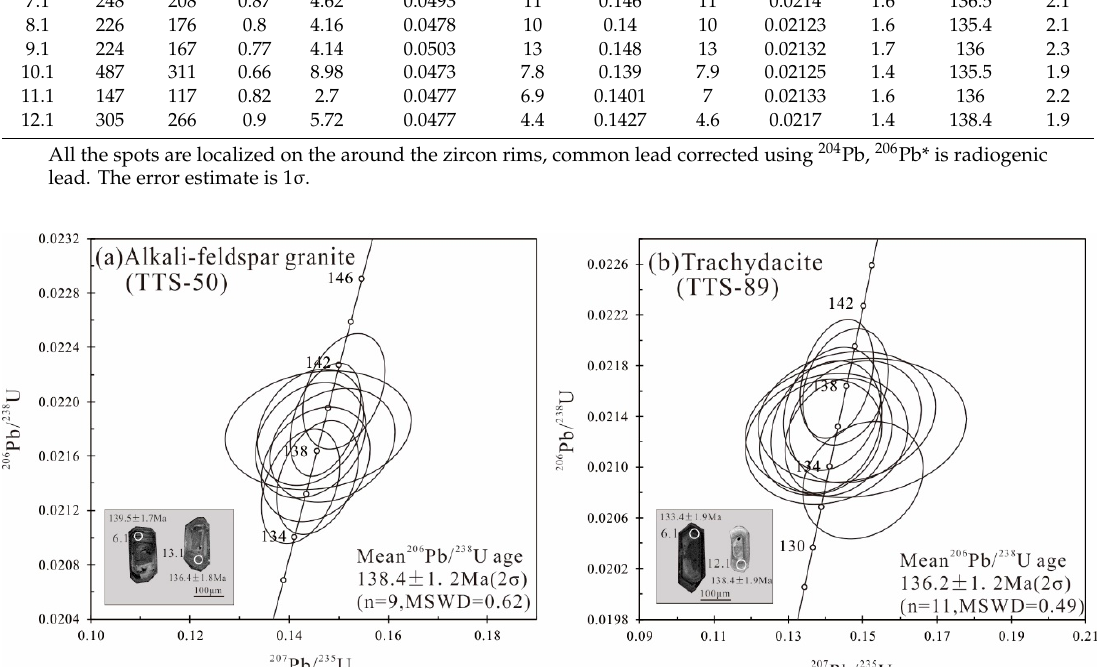
Figure 6. ( a , c ) Chondrite-normalized [31] REE patterns and ( b , d ) primitive mantle-normalized [32] trace element patterns for the Tiantangshan alkali-feldspar granite and trachydacite. 4.3. Nd Isotopes of Whole Rocks